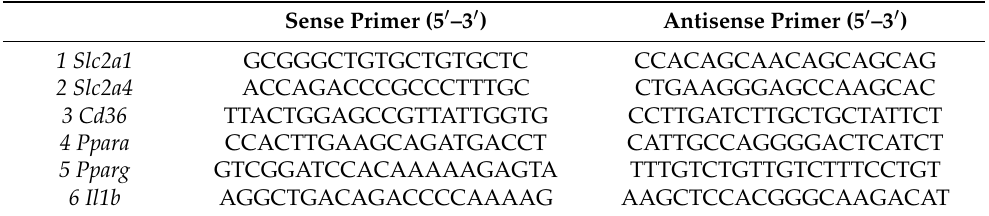
Table 1. Specific primer pairs used for qPCR